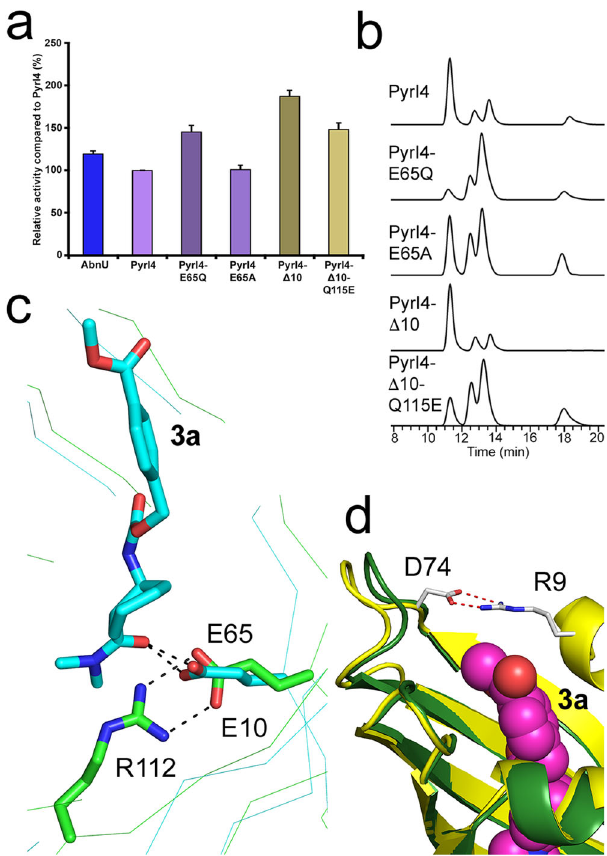
Fig. 6 Quanti fi cation of product, stereoselectivity and intermolecular interactions of PyrI4 and its mutants. a Quanti fi cation of the total product ( 3a ) formed when 1a and 2 were incubated with AbnU, PyrI4 and its mutant by LC-SRM method. Error bars re fl ect the standard deviation obtained from three independent experiments. b Stereoselectivity of the 3a formed in the presence of PyrI4 and its mutant enzymes analyzed by chiral- HPLC followed by HRMS method. Note that stereoselectivity is similar in catalysing the 3a from 1a and 2 with wild type PyrI4 and PyrI4- Δ 10. Mutation of E65 and Q115 leads to loss in stereo selectivity. c E10 in AbnU (green) is placed structurally equivalent position of E65 in PyrI4 (cyan). E10 forms a salt bridge with R112. Absolute stereoselectivity and higher yield of 3a with AbnU could be due to the salt bridge that limits the orientational fl exibility and increased activation of the dienophile 2 . d Superposition of full-length PyrI4 (PDB: 5BU3) and PyrI4- Δ 10- 3a complex showing the salt bridge (R9-D74) at the N-terminal α 0 fl exible loop capping the product 3a and possibly slowing the exchange of substrate/product.